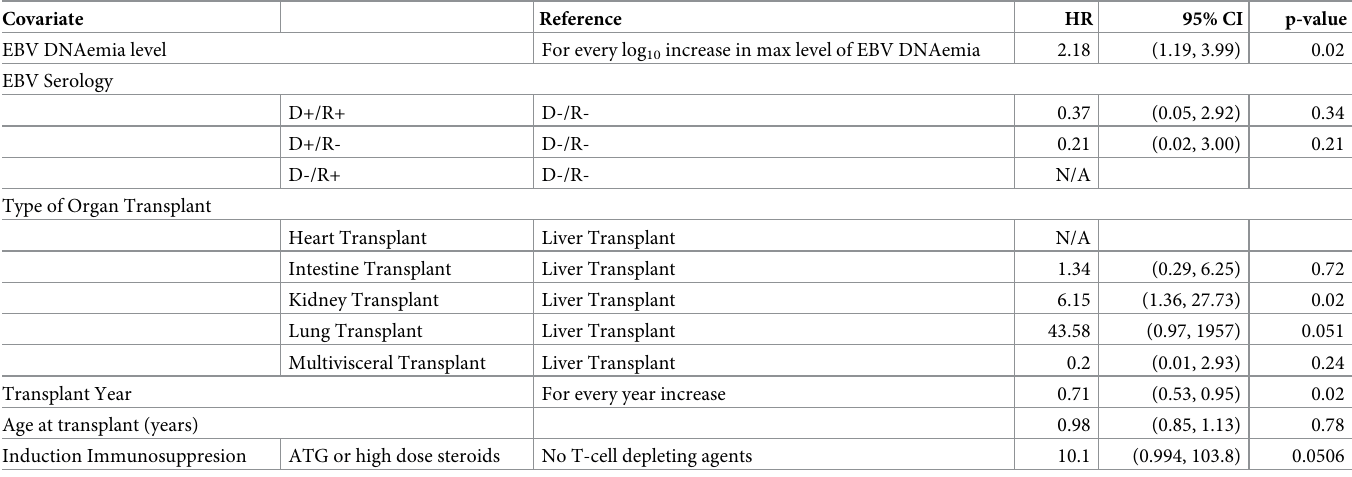
Table 6. Adjusted hazards ratios (HR) for significant covariates for the outcome time to PTLD.